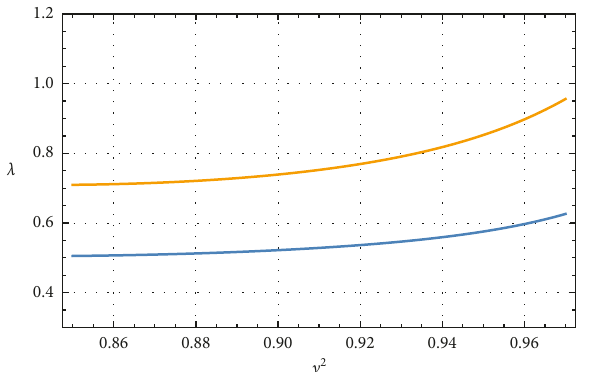
Figure 2: Values of the coupling constant, λ , in terms of the parameter c 2 obtained in this work at T pseudopotential is μ ∗ � 0 . 1 for both curves; E � 100meV for the upper one. E lower curve and E ph and 0.248,